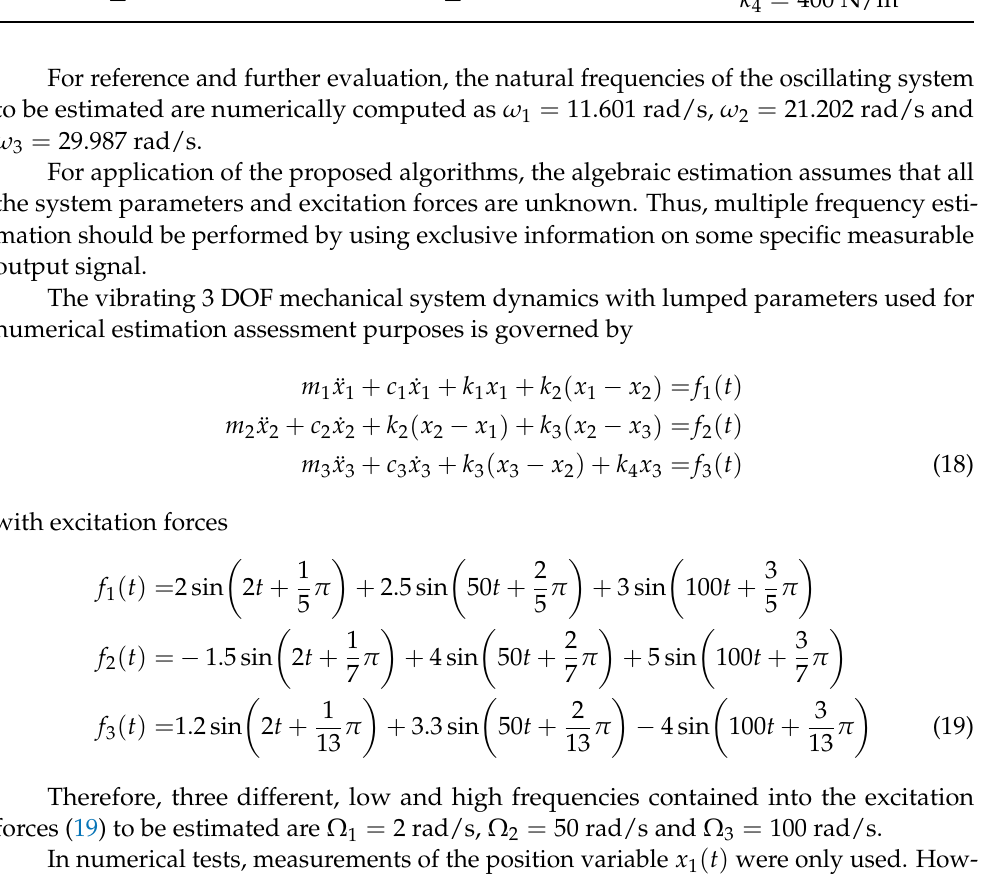
Table 1. Parameters of the 3 Multiple Degrees-Of-Freedom (DOF) forced vibrating mechanical system. Mass [kg] Viscous Damping [Ns/m] Stiffness [N/m] m 1 =